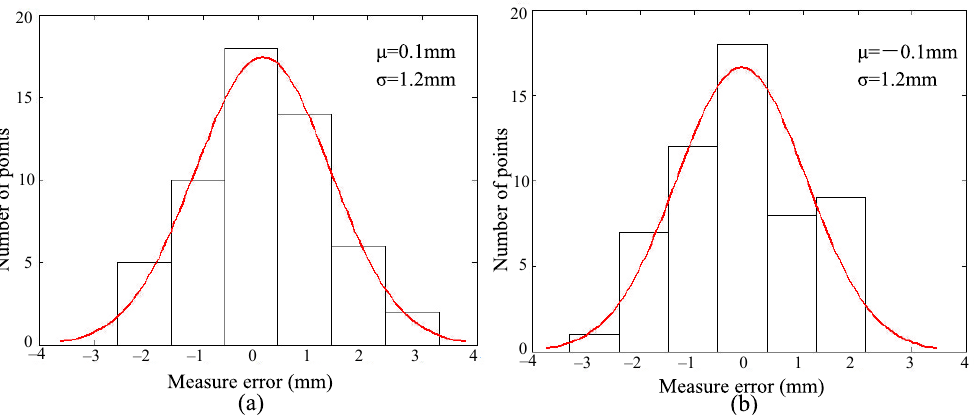
Figure 17. Histograms of differences between measurements by TLS and two measurements of the station as a whole: ( a ) denotes the quantitative distribution of the measurement error of the proposed monitoring system, which uses the first set of data from the station as the reference; ( b ) denotes the quantitative distribution of the measurement error of the proposed monitoring system, which uses the second set of data from the station as the